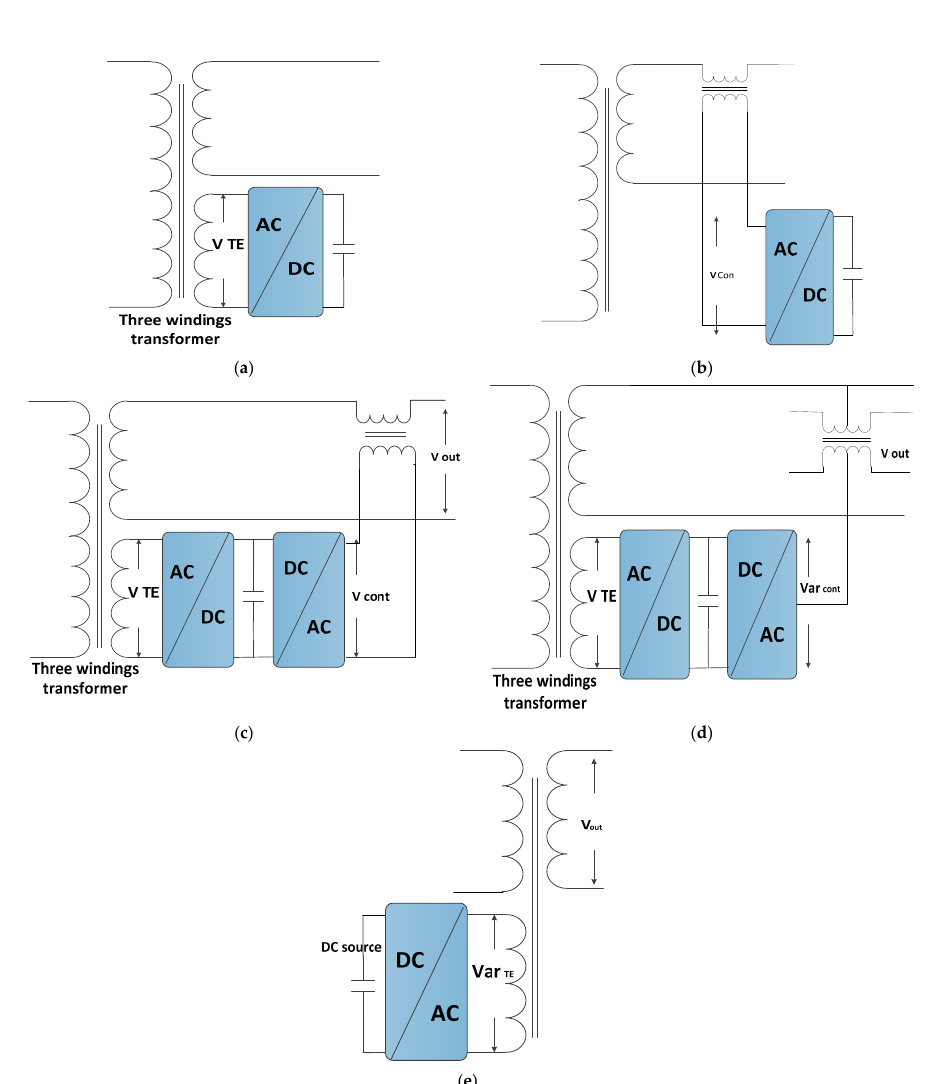
Figure 3b Conceptual 2 Figure 3c Conceptual 3 Figure 3d Conceptual 4 Figure 3e Conceptual 5 Energies 2021 , 14 , x FOR PEER REVIEW